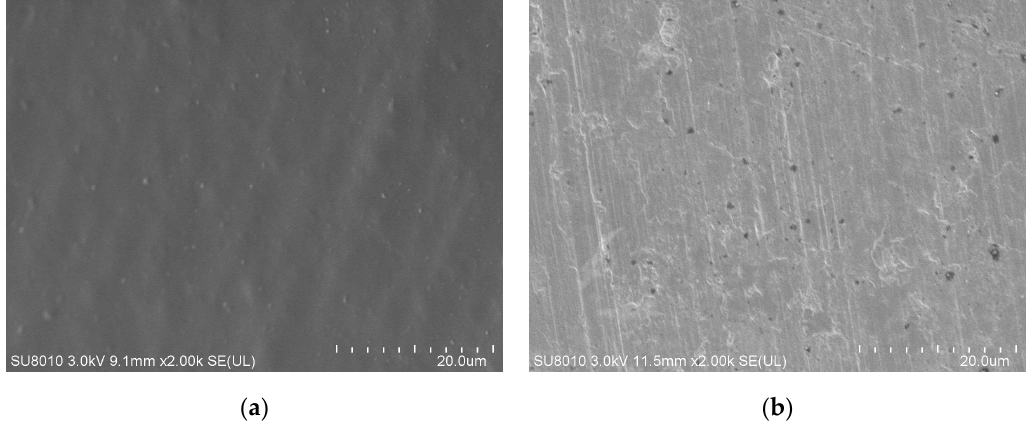
Figure 8. Scanning electron microscope images of the PEDOT/PSS film: ( a ) Dried at the room temperature for 24 hours; ( b ) dried in an air convection oven at 120 °C for 15 minutes.